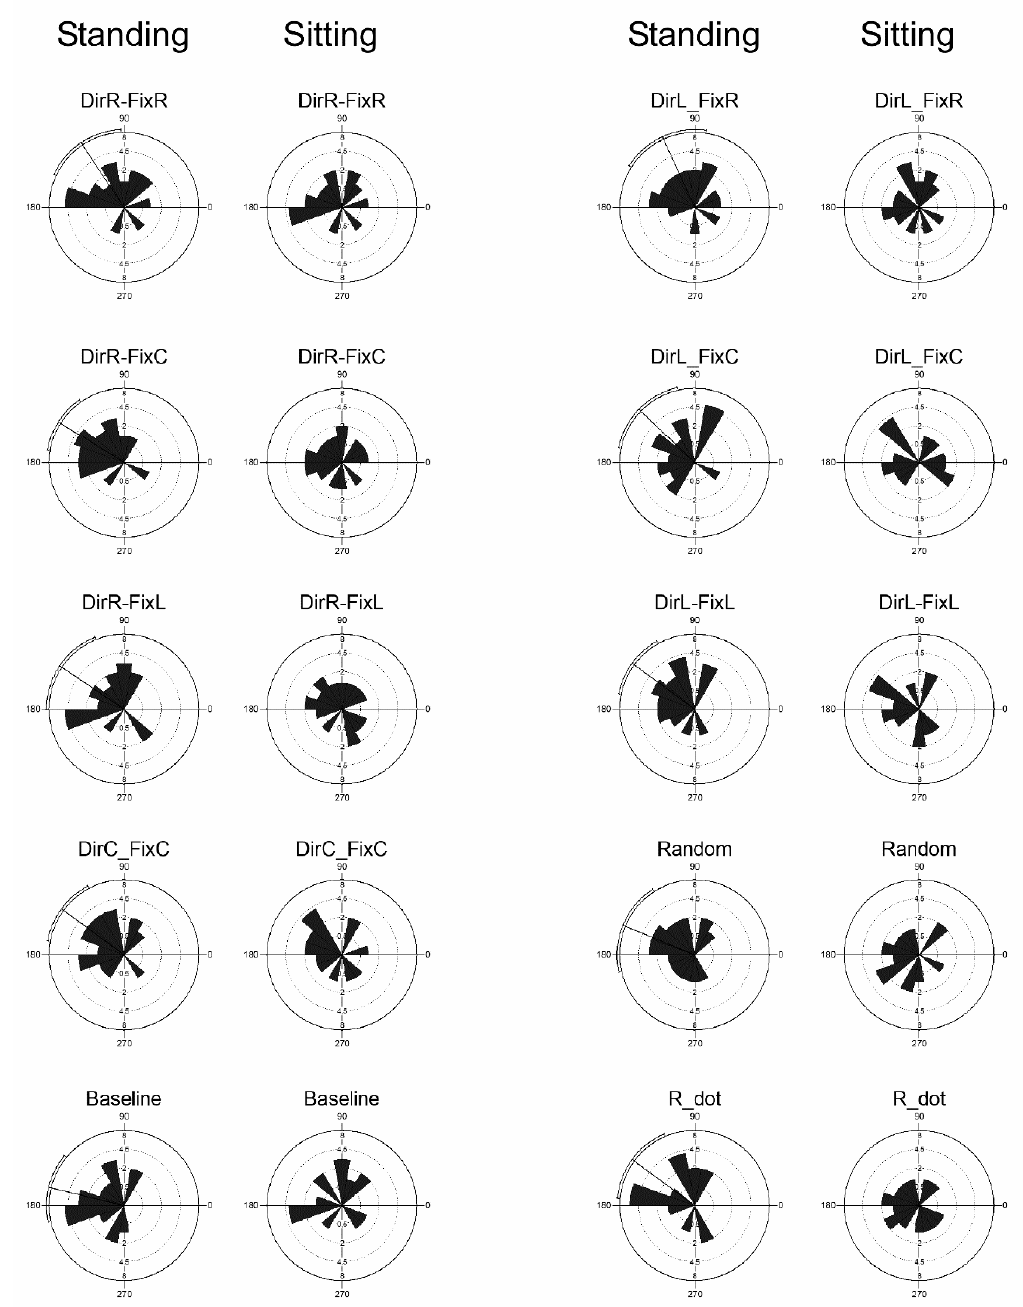
Figure 8. Distributions of microsaccade directions in all stimuli in both sitting and standing conditions. Mean vectors were computed for each trial. Solid line crossing each diagram indicates the significant mean vectors, curved line outside the circle indicates the circular SD. Bars are 20° width. Conventions are as in Figure 1.